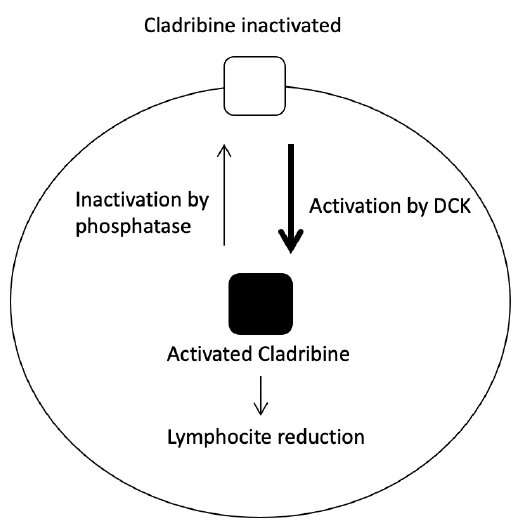
Figure 6. Mechanism of action of cladribine; DCK: Deoxycitidine